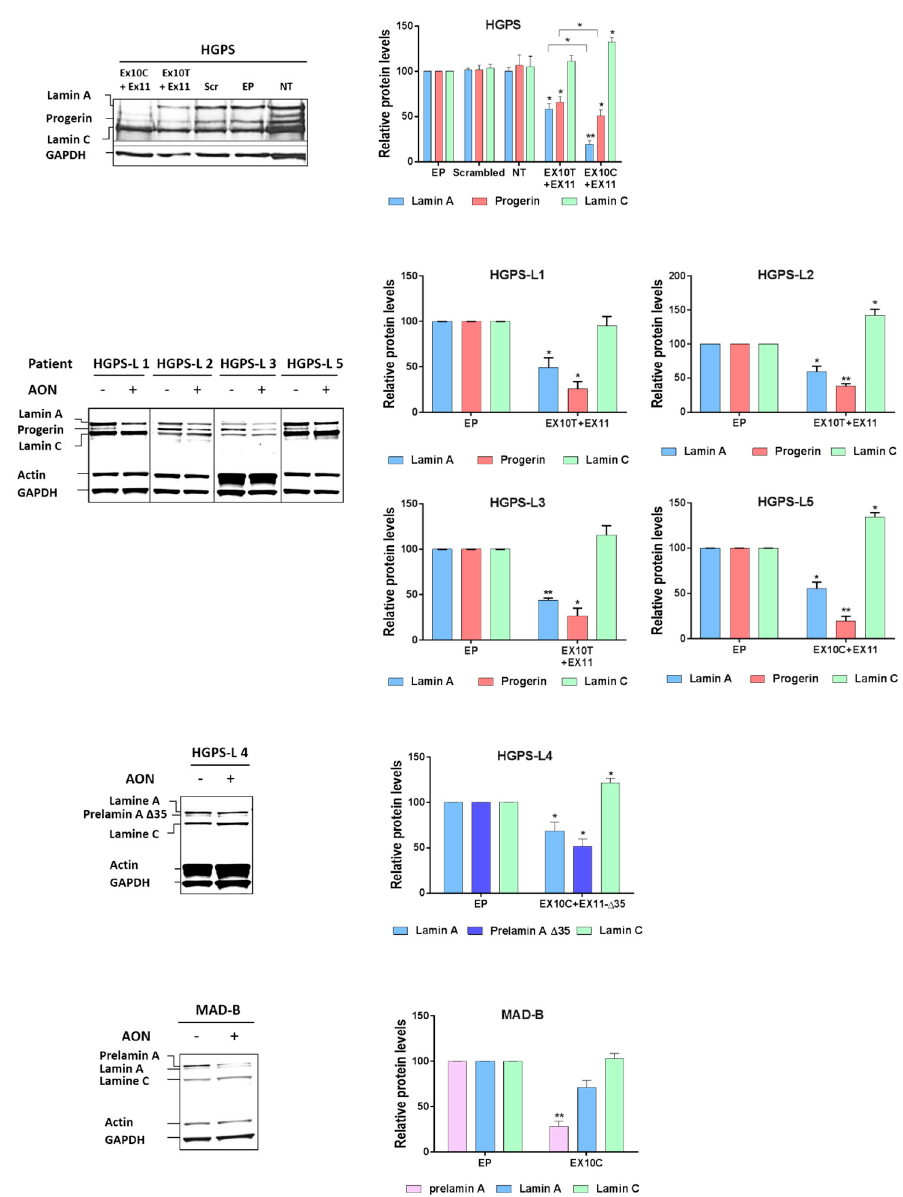
Figure 3. Antisense morpholinos reduce aberrant Prelamin A protein levels in Hutchinson-Gilford Progeria Syndrome-like (HGPS-like) and Mandibuloacral Dysplasia type B (MAB-B) patient cells. Left panels: Western blotting evaluation of Lamin A/C, Progerin, Prelamin A, Prelamin A ∆ 35, actin and GAPDH in whole lysates from HGPS, HGPS-like and MAD-B fibroblasts treated with Endoporter ( − ) (control), antisense morpholinos: AON (+). Right panels: Lamin A/C, Progerin, Prelamin A, Prelamin A ∆ 35 expression levels were normalized to GAPDH values using ImageJ software. (mean ± SEM, n = 3, Student’s t-test, * p < 0.05, ** p < 0.01. AON-treated vs. control, EP-treated cells).